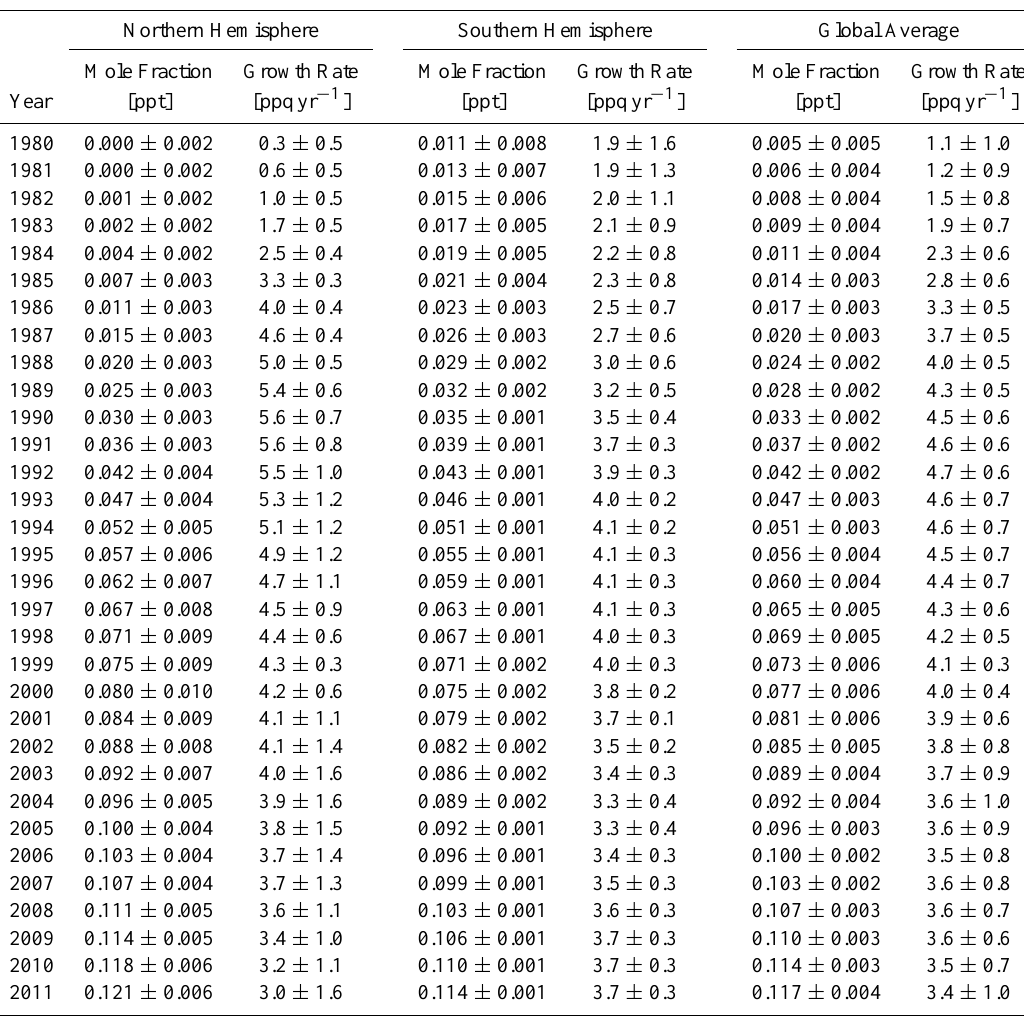
Table 6. Northern and Southern Hemisphere and Global Average Annual Mean Mole Fractions and Growth Rates and Associated Uncer- tainties 1980-2011 for C 7 F 16 .